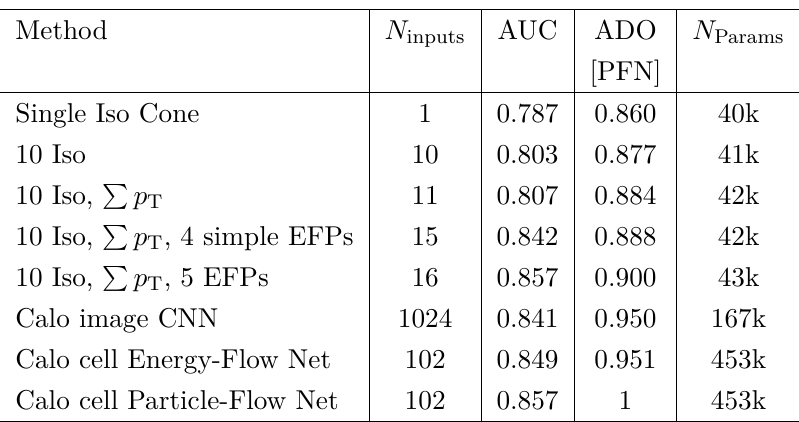
Table 1. Summary of performance (AUC) in the prompt muon classification task for various network architectures and input features. Statistical uncertainty in each case is ± 0 . 001 with 95% confidence, measured using bootstrapping over 100 models. Uncertainty due to the initial conditions of the network is found to be negligible. Also shown are the number of inputs to and parameters of each